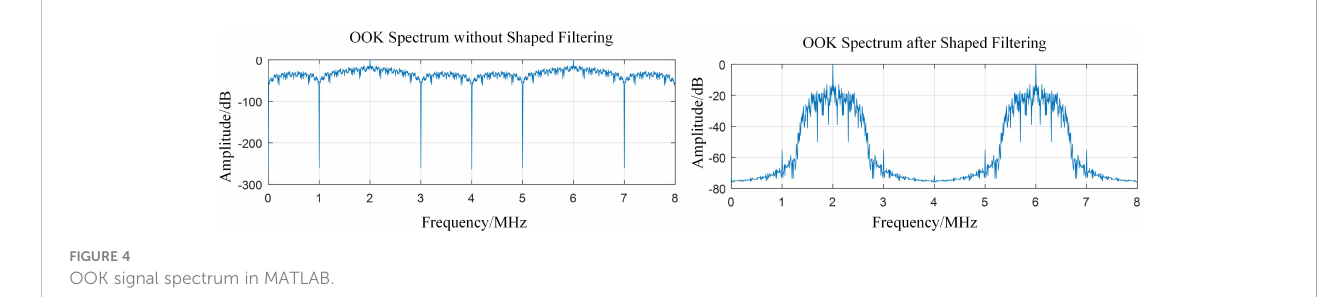
FIGURE 4 OOK signal spectrum in